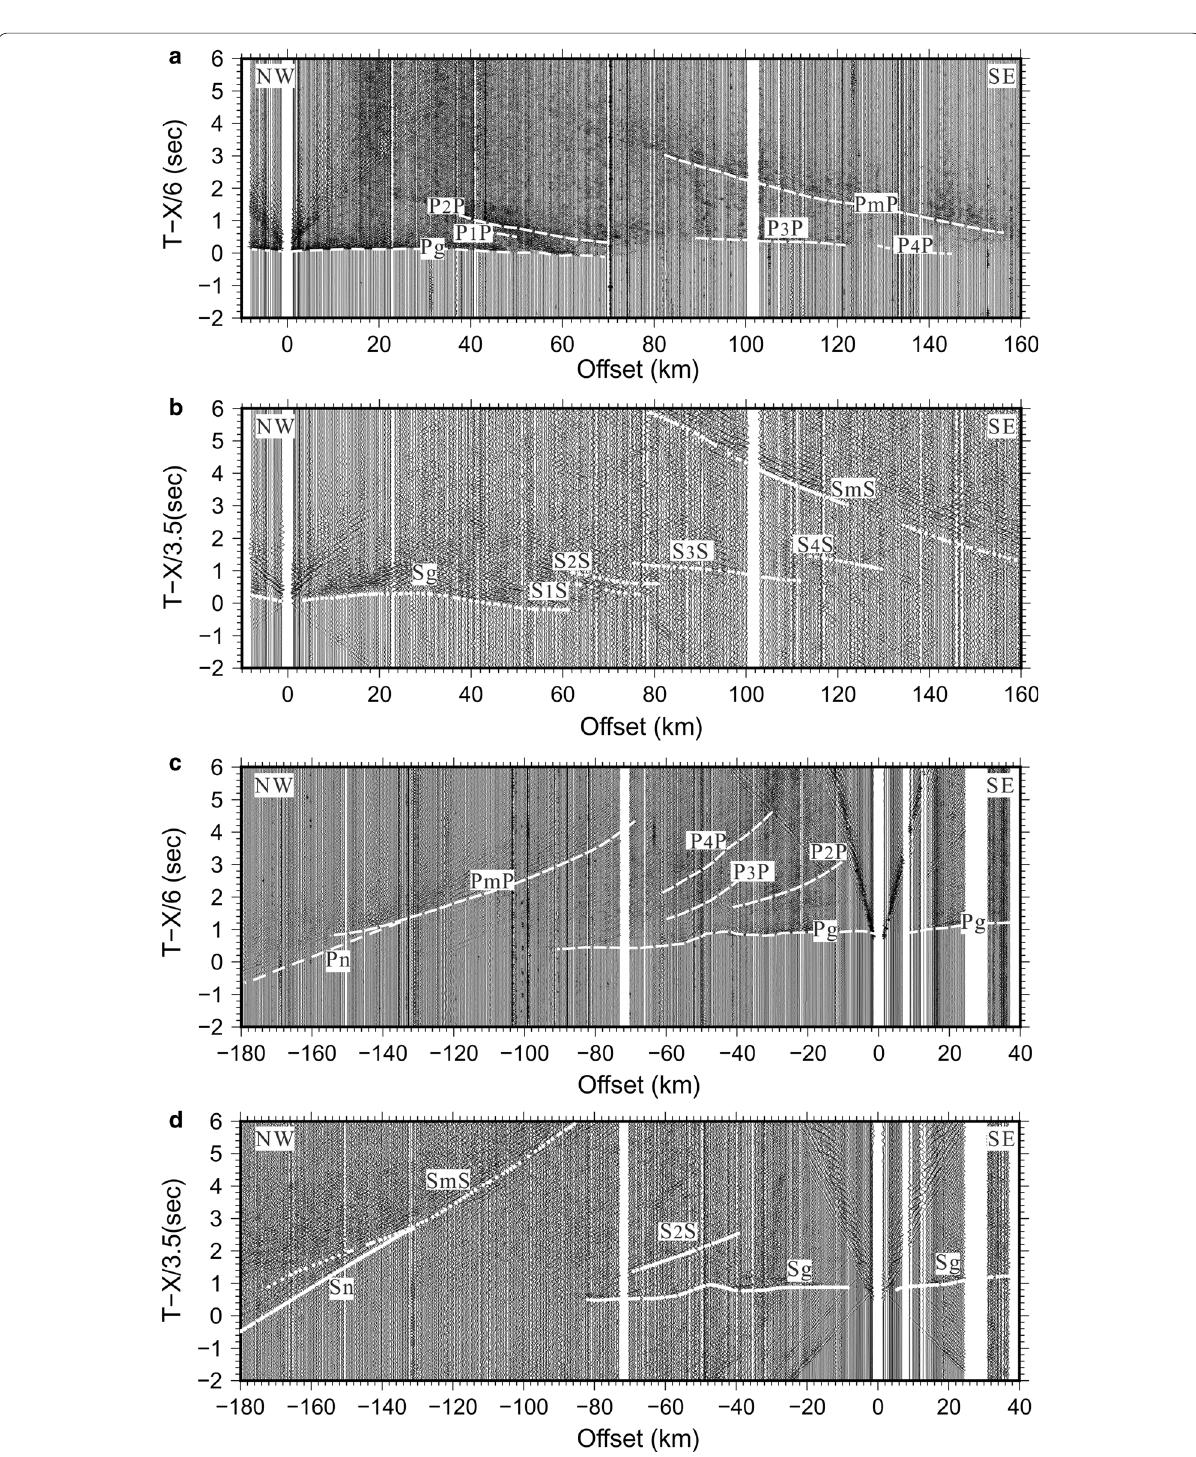
Fig. 3 Record section generated by the westernmost shot SP1 and easternmost shot SP2 are plotted at a reduction velocity 6 km/s, and the amplitudes are normalized for each trace. The white dashed lines indicate the picked travel times. These is no filter for the P-wave record section, while an Ormsby band-pass filter of 2–12 Hz is used for the S-wave record section to enhance the signal-to-noise ratio. a The P-wave record section of SP1. Six principal seismic phases (Pg, P1P, P2P, P3P, P4P, and PmP) have been identified based on the reciprocal traveltimes. b The S-wave record section of SP1. Six principal seismic phases (Sg, S1S, S2S, S3S, S4S, and SmS) have been identified. c The P-wave record section of SP2. Six principal seismic phases (Pg, P1P, P3P, P4P, PmP, and Pn) have been identified. The uppermost mantle refraction Pn is only visible in the record section of SP2. d The S-wave record section of SP2. After a filter, only four principal seismic phases (Sg, S2S, SmS, and Sn) have been